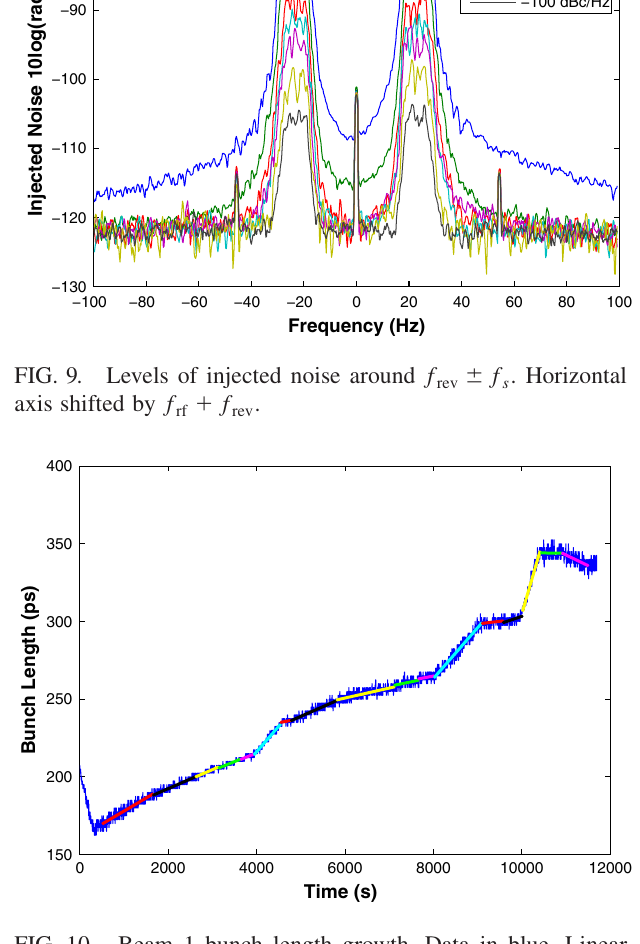
FIG. 10. Beam 1 bunch length growth. Data in blue. Linear segments correspond to different noise injection